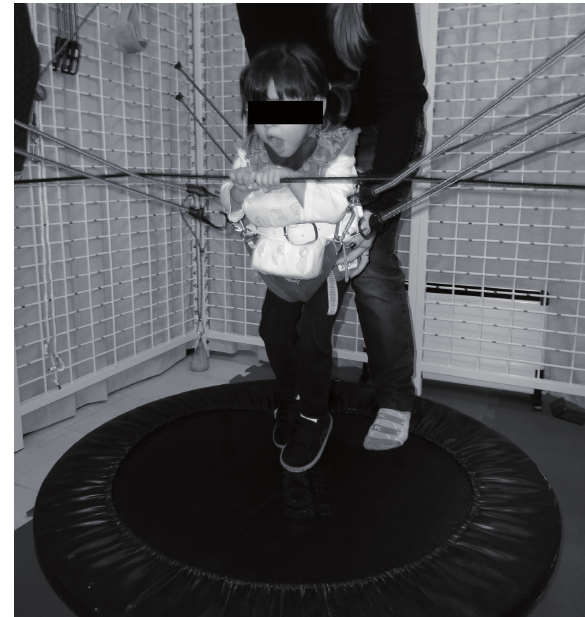
Figure 5 - Spider cage with extra equipments Source: Research